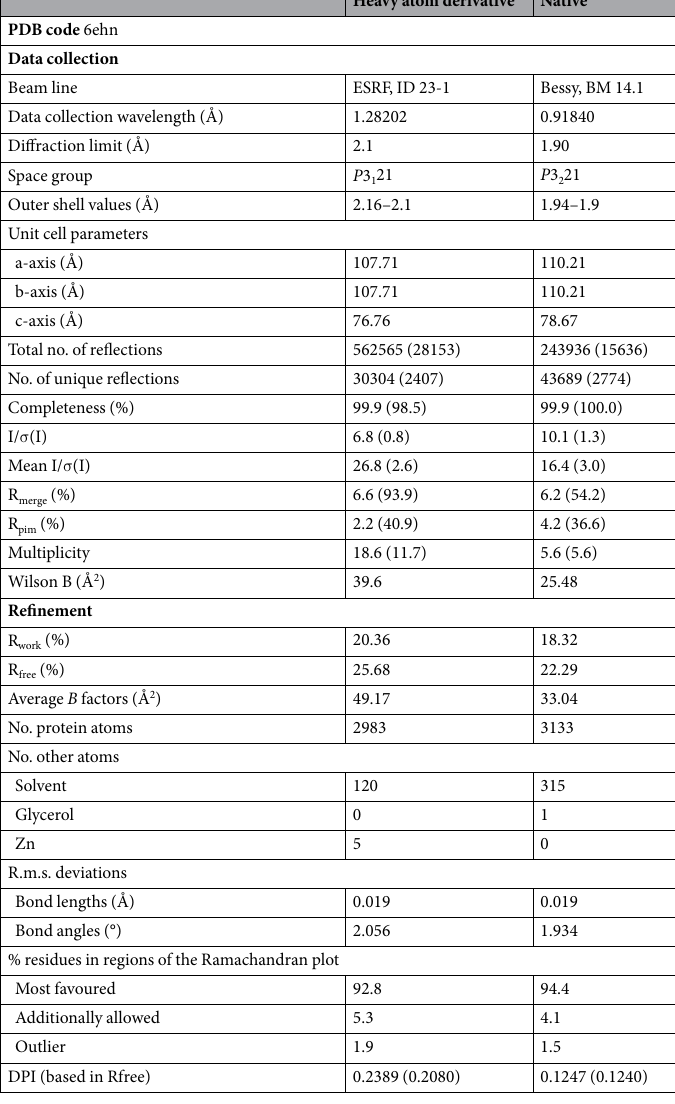
Table 3. X-ray crystallographic data-collection and refinement statistics for